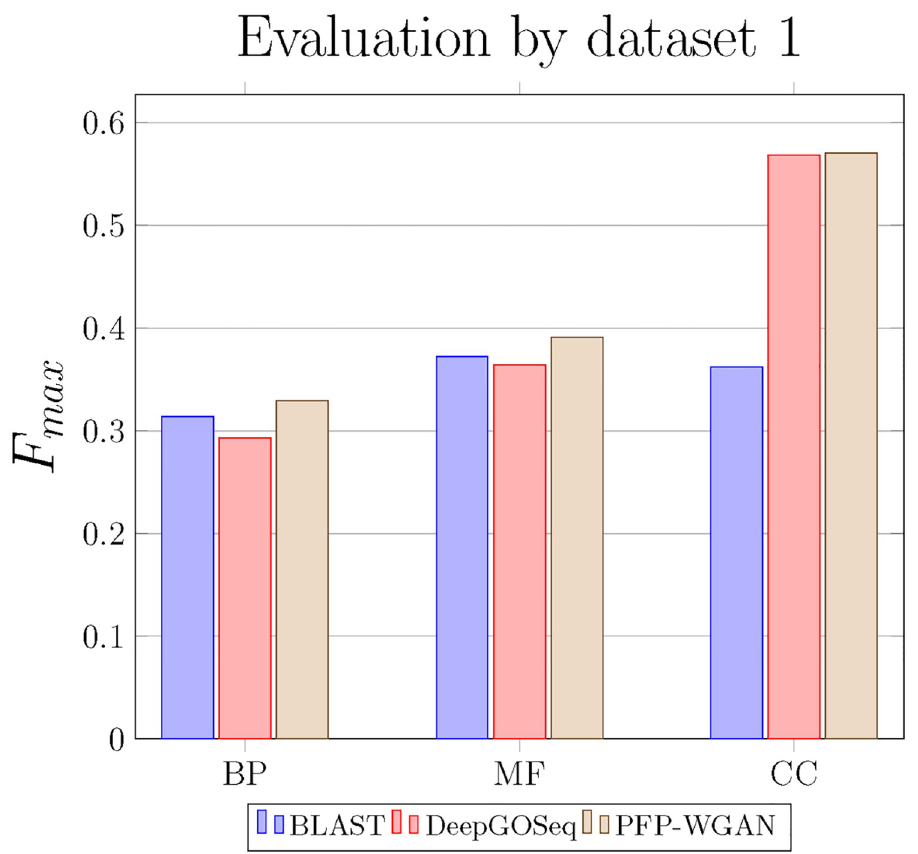
Fig 2. Comparison of BLAST, DeepGO-Seq and PFP-WGAN on dataset 1. The F max measure shows the superiority of PFP-WGAN in all three parts of the GO.